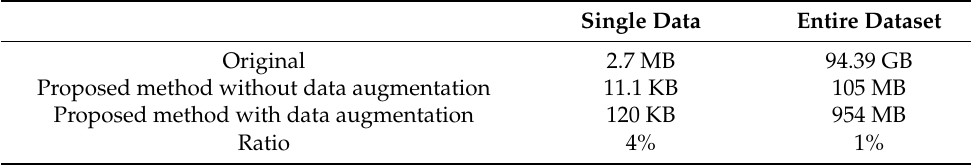
Table 3. Number of words and sentences in the KETI sign language dataset.